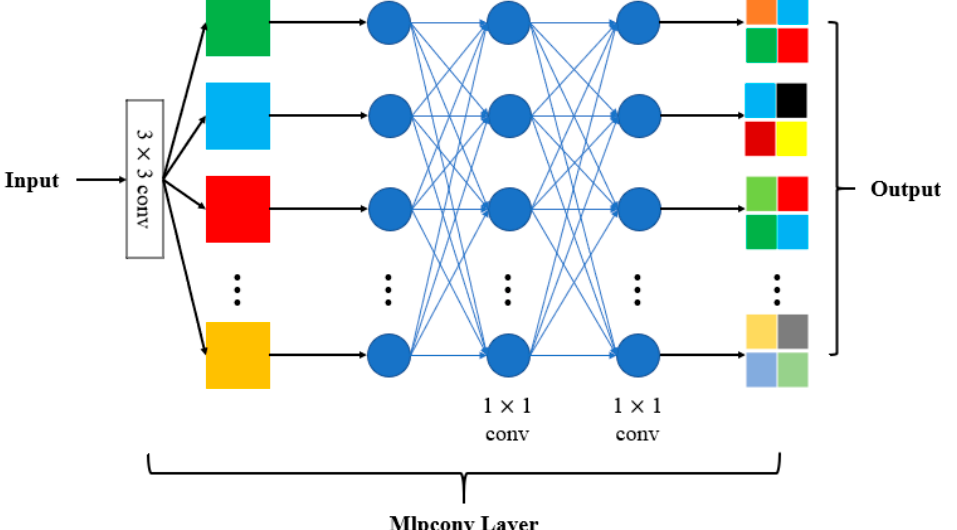
Figure 4. Microstructure of a building block.